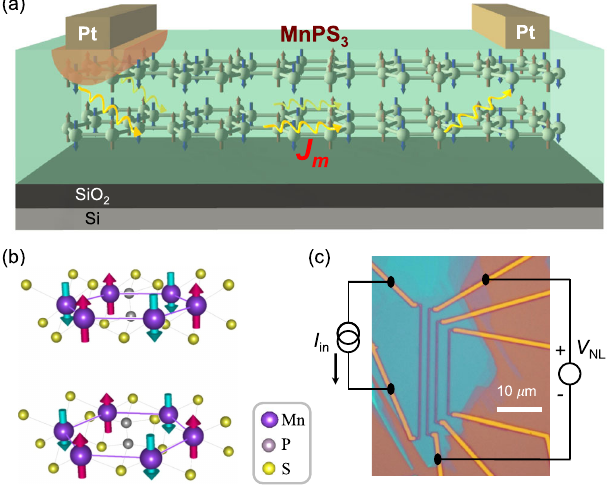
FIG. 1. Illustration of magnon transport in quasi-2D antiferro- magnet MnPS 3 devices. (a) Schematic of magnon transport in the quasi-2D MnPS 3 . J m represents the magnon-mediated spin current. The left Pt electrode is used as magnon injector via thermal spin injection, and the right Pt electrode is used as magnon detector via inverse spin Hall effect. (b) The crystal and spin structures of van der Waals antiferromagnet MnPS 3 . (c) Schematic of nonlocal measurement on a typical MnPS 3 device via the low-frequency lock-in technique. The thickness of the MnPS 3 flake is 8 nm determined via atomic force microscopy (Supplemental Material, Fig. S2